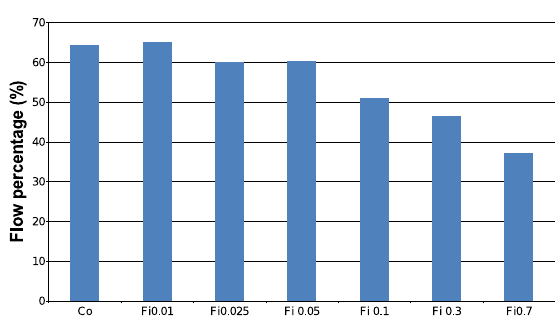
Figure 1. The flow property of different